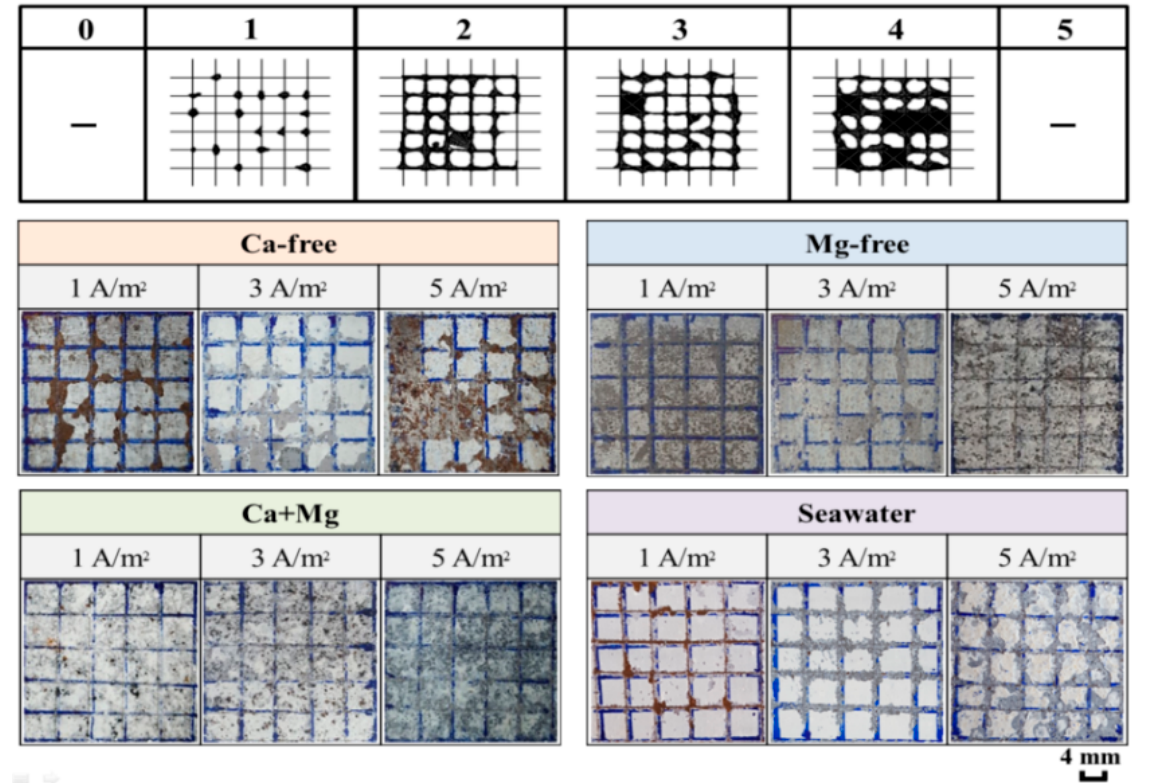
Figure 7. Taping test (ISO 2409) for adhesion properties of calcareous deposit films after 24 h.